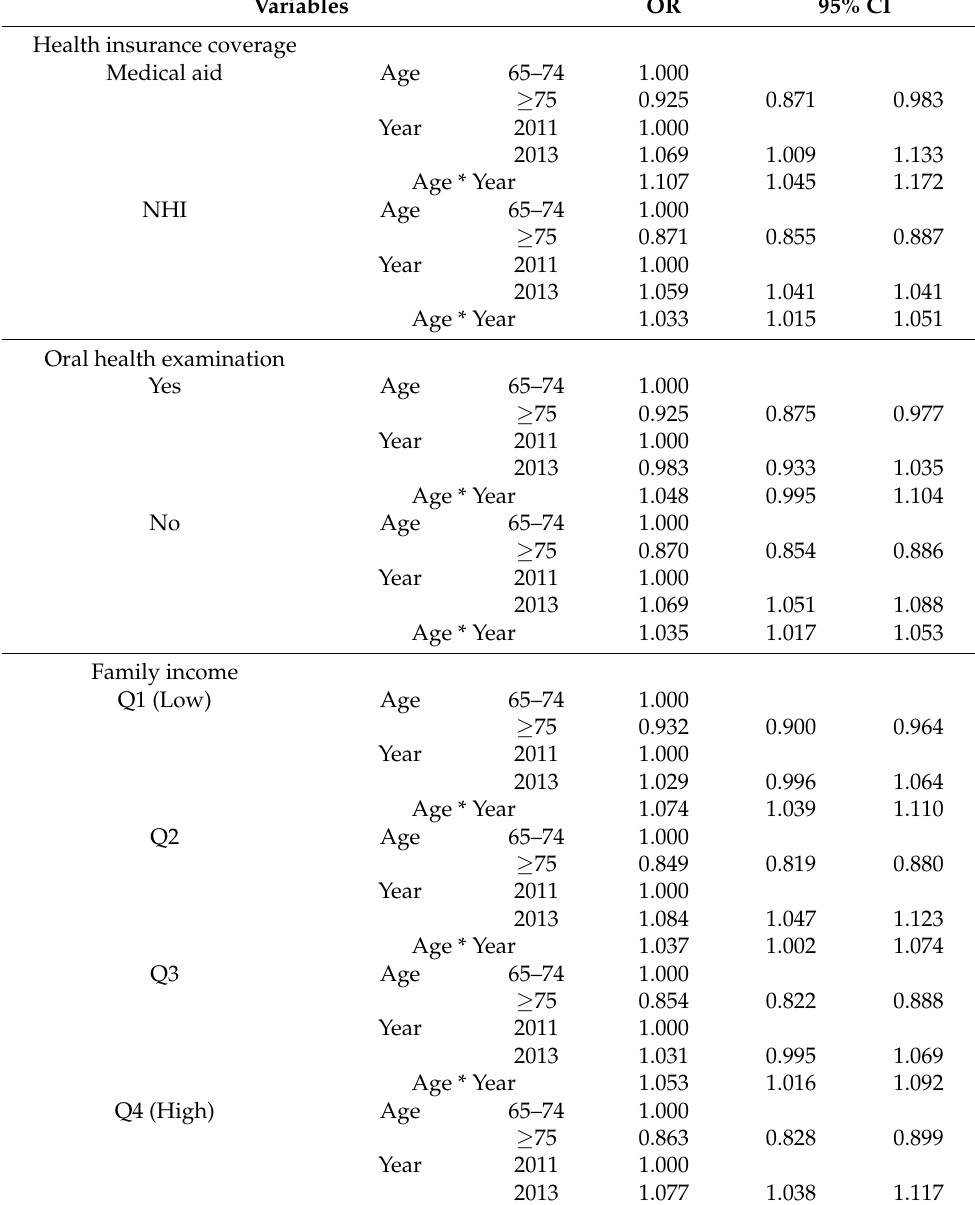
Table 3. Difference-in differences (DID) analysis comparing target elderly individuals before and after coverage. Variables OR 95%